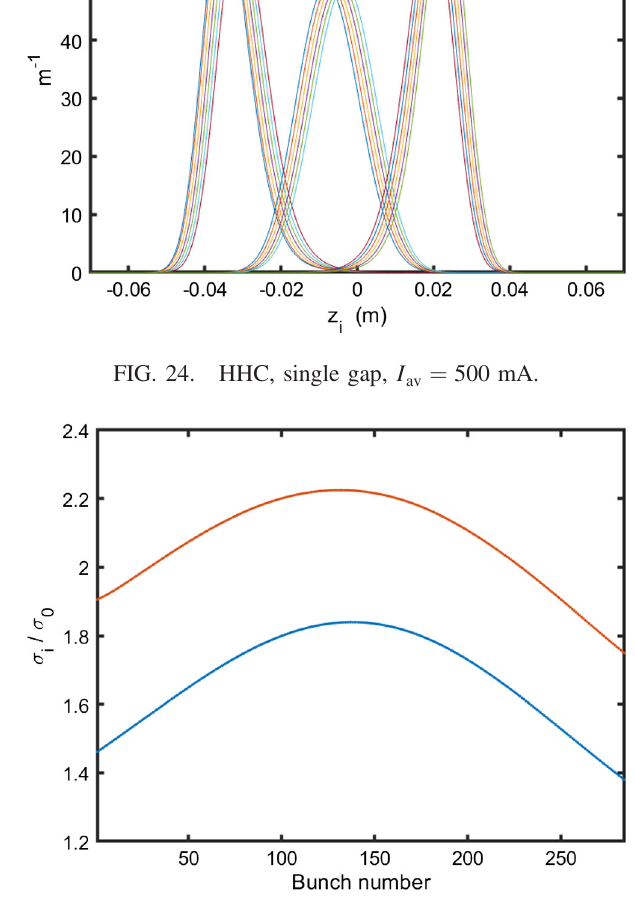
FIG. 25. Single gap, bunch lengthening ratio, for HHC þ MC (blue) and with HHC alone